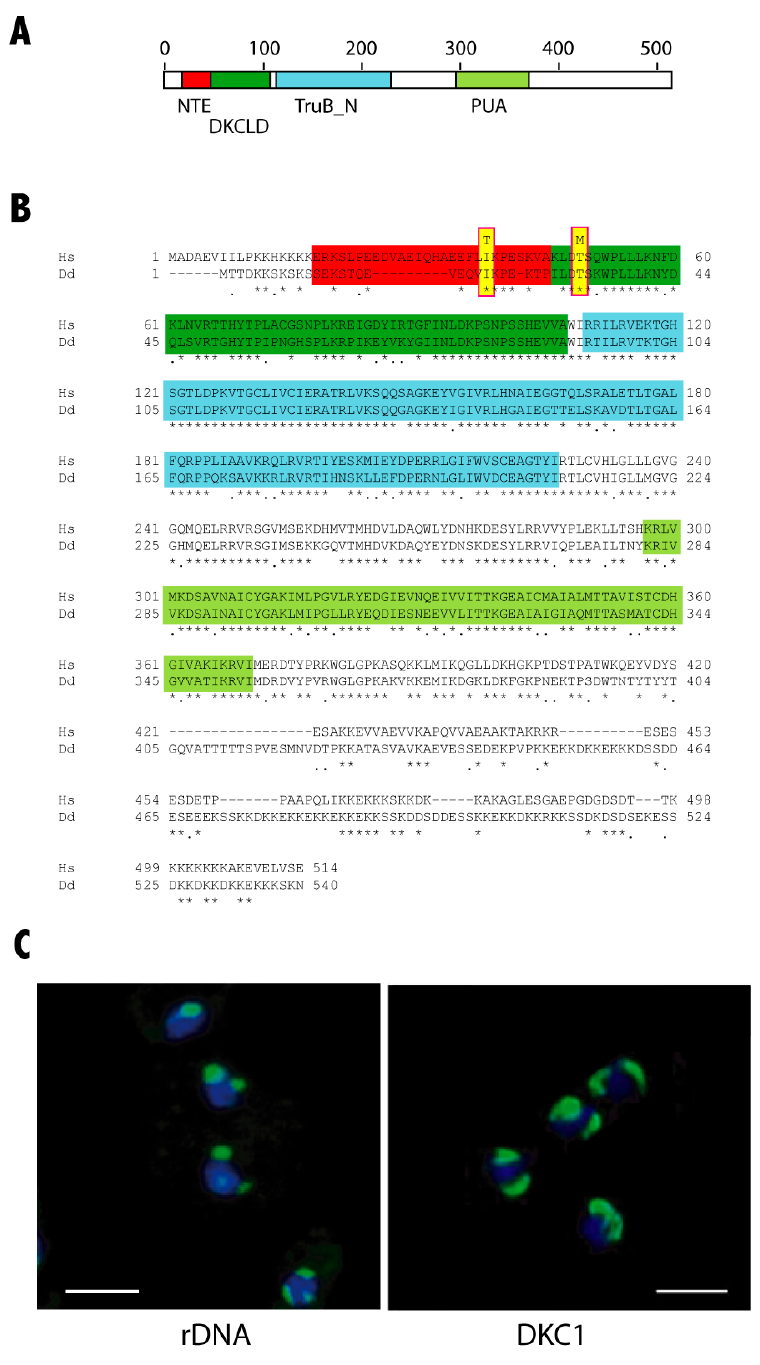
Figure 1. Protein sequence and expression of D. discoideum dyskerin, ( A ) Schematic representation of dyskerin conserved domains. The conserved domains N-terminal extension (NTE), dyskerin-like domain (DSKLD), pseudouridin synthase catalytic domain (TruB_N) and RNA-binding domain (PUA) are represented according to the human protein. Amino acid positions are shown in the upper part of the diagram. ( B ) Comparison of the human (Hs) and D. discoideum (Dd) dyskerin amino acid sequences. Functional conserved domains are indicated using the same color code as in Panel A. The amino acids mutated in the D. discodeum protein in this study are highlighted in yellow. ( C ) D. discoideum nucleoli, one or two in each cell, were identified in the left panel by hybridization with a probe specific for the 26S ribosomal RNA. The right panel shows the expression of a D. discoideum dyskerin-GFP fusion protein after transfection of the cells with a dyskerin expression vector. Nuclei were stained with DAPI and are shown in blue color. Scale bars correspond to a distance of 5 µ